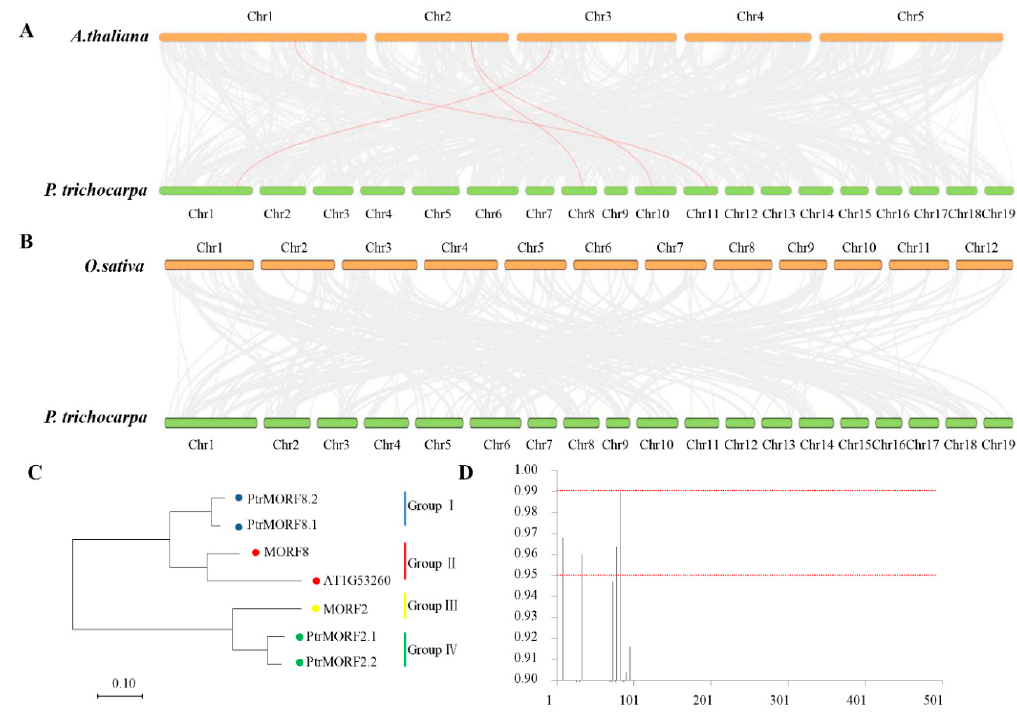
Figure 6. Synteny analysis of MORF genes between poplar and two representative plant species. ( A , B ) Gray lines in the background indicate the collinear blocks within poplar and other plant genomes, while the red lines highlight the syntenic MORF gene pairs. ( C ) The phylogenetic relationship of 7 members of four pairs. ( D ) The Bayes Empirical Bayes (BEB) probabilities for sites in the positively selected class ( ω > 1). The x-axis denotes position in the amino acid alignment.